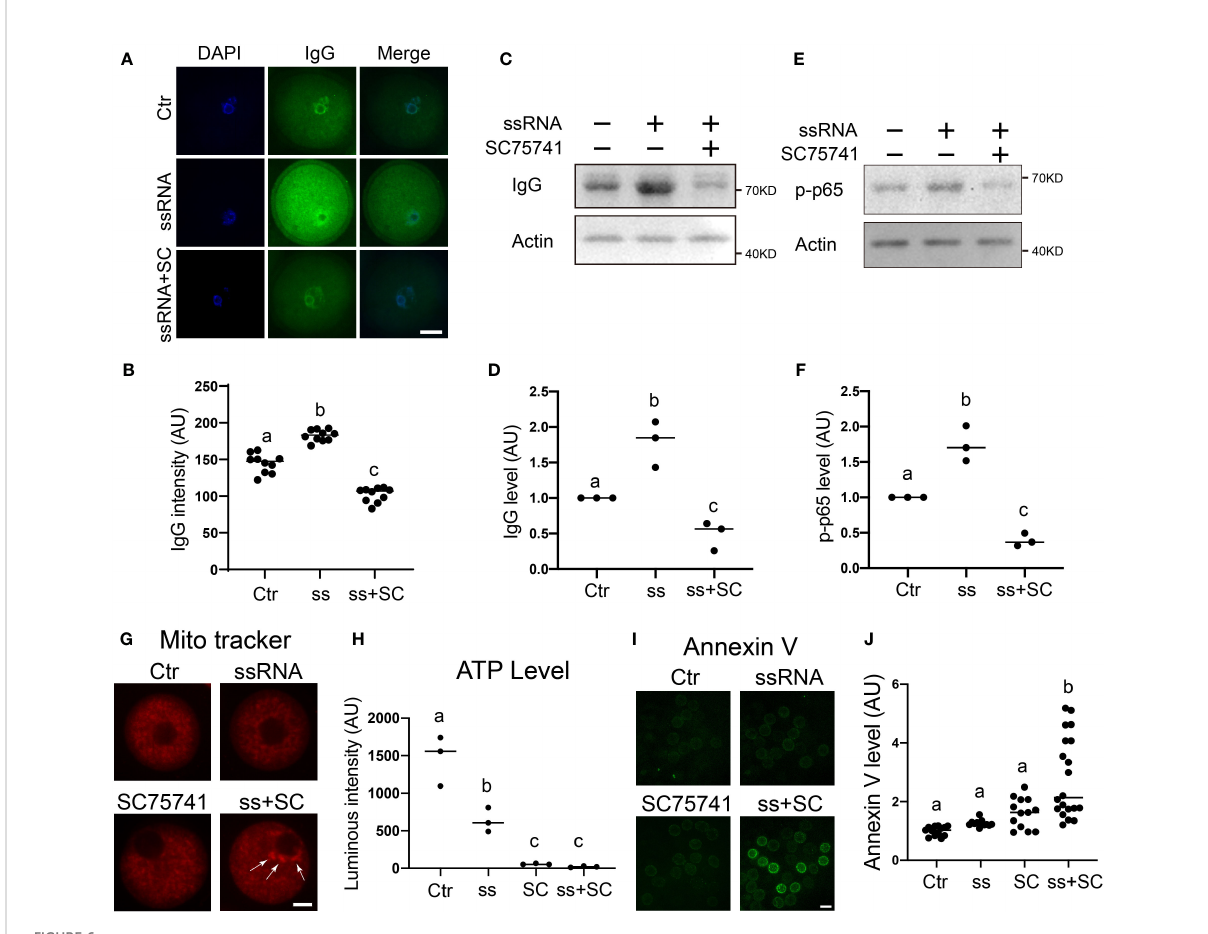
FIGURE 6 IgG functions to protect mitochondria integrity in response to virus ssRNA stimuli (A, B) Immuno fl uorescence shows that IgG intensity signi fi cantly increased in virus ssRNA-injected oocytes. DNA in blue, IgG in green. (C – F) Western blot and quanti fi cation show that upon virus ssRNA injection, the IgG level signi fi cantly increased, whereas the NFKB inhibitor SC75741 signi fi cantly brought the ssRNA-induced IgG increment back to the control level. The p-p65 level also signi fi cantly increased upon ssRNA injection, whereas the SC75741 signi fi cantly brought the ssRNA-induced p-p65 increment back to the control level. (G, H) Mitochondria live fl uorescence showed that both ssRNA injection and NFKB inhibition caused increased mitochondria aggregation, accordingly ATP level signi fi cantly decreased upon either treatment. While ssRNA injection combined with NFKB inhibition further exacerbate mitochondria aggregation, accordingly ATP level further decreased. (I, J) Live fl uorescence showed that early apoptotic level indicated by Annexin V signi fi cantly increased upon ssRNA injection combined with NFKB inhibition. Actin was used as a loading control. Scale bars, 20 m m. Difference lower-case letters indicate signi fi cant difference between two